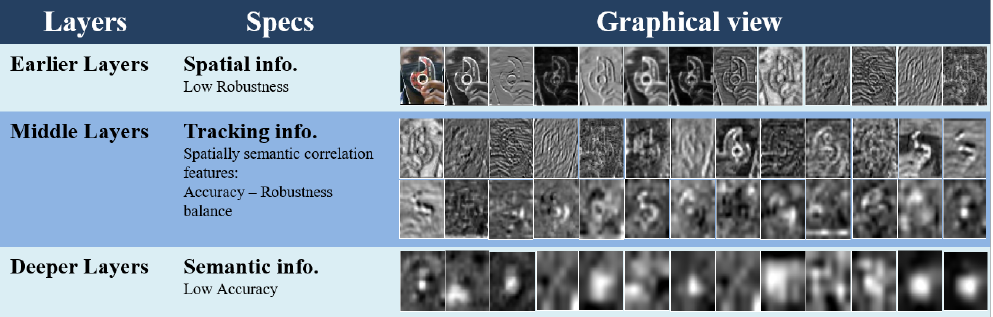
Figure 3. Graphical view of spatially semantic correlation features. From Left to right, top to bottom we have a sequence of activations from a deep convolutional neural network (CNN) (ResNet50 [13] for our case), where the first (top) row consists of Earlier layer activations poor in robustness, and the last (bottom) row consists of deeper layer activations poor in accuracy. To balance the robustness—accuracy trade-off, our method suggests to use middle layer activations (2 middle rows) rich in both spatial and semantic